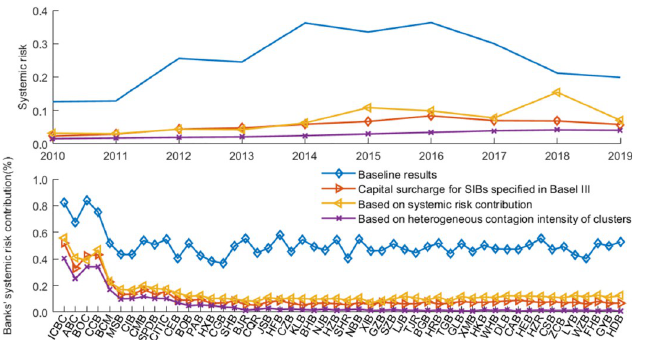
Fig 14. Overall systemic risk and banks’ systemic risk contribution with different capital